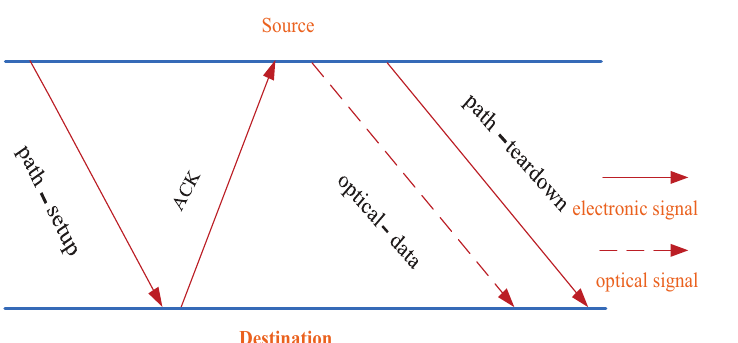
Figure 5. Mechanism diagram of optical circuit switching.